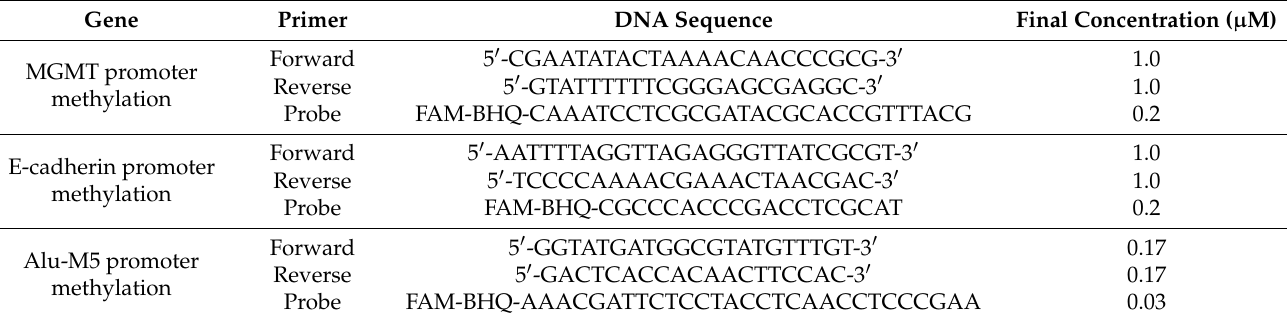
Table 1. Primers and probes used to detect MGMT, E-cadherin, and Alu-M5 promoter